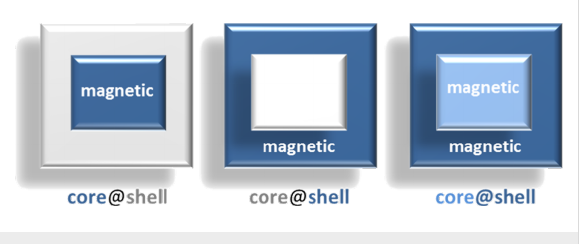
Figure 1: Classification of core–shell SCO